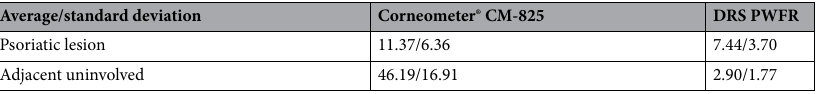
Table 1. The averages and the standard deviations of the DRS derived PWFR values and the Corneometer readings measured at the psoriatic lesion sites and their adjacent uninvolved sites of 15 psoriasis vulgaris patients.